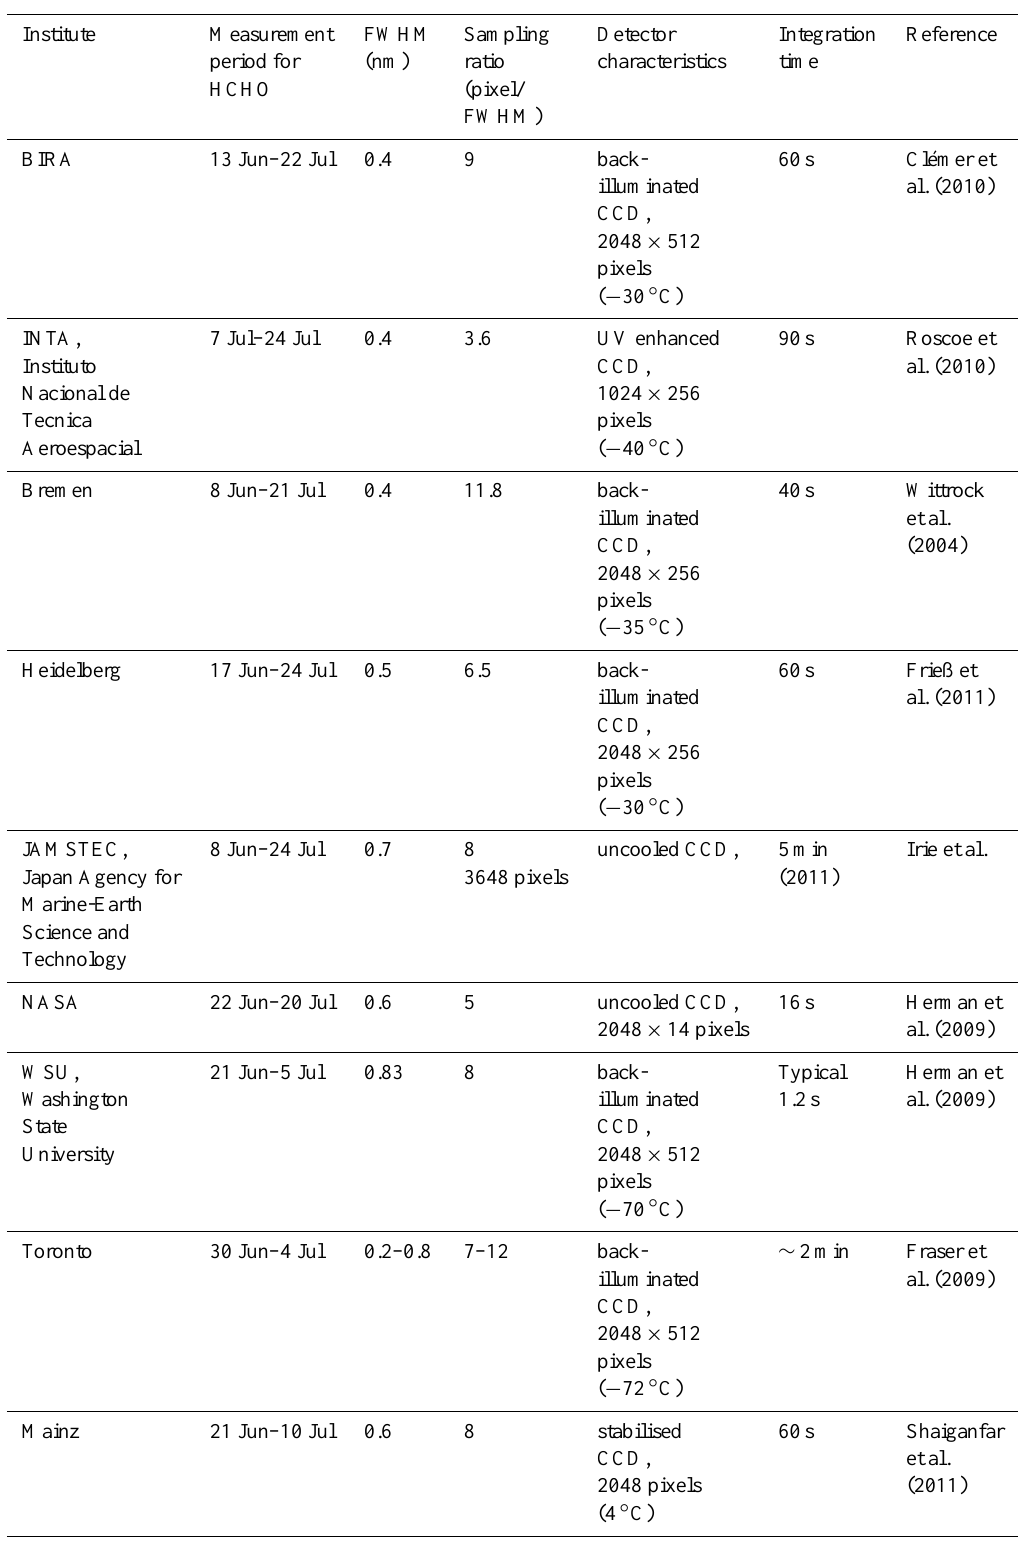
Table 1. Primary characteristics of the spectrometers taking part in the HCHO intercomparison